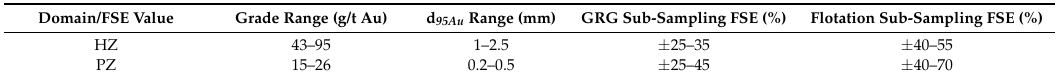
Table 17. FSE values for sub-sampling. All FSEs at 90%